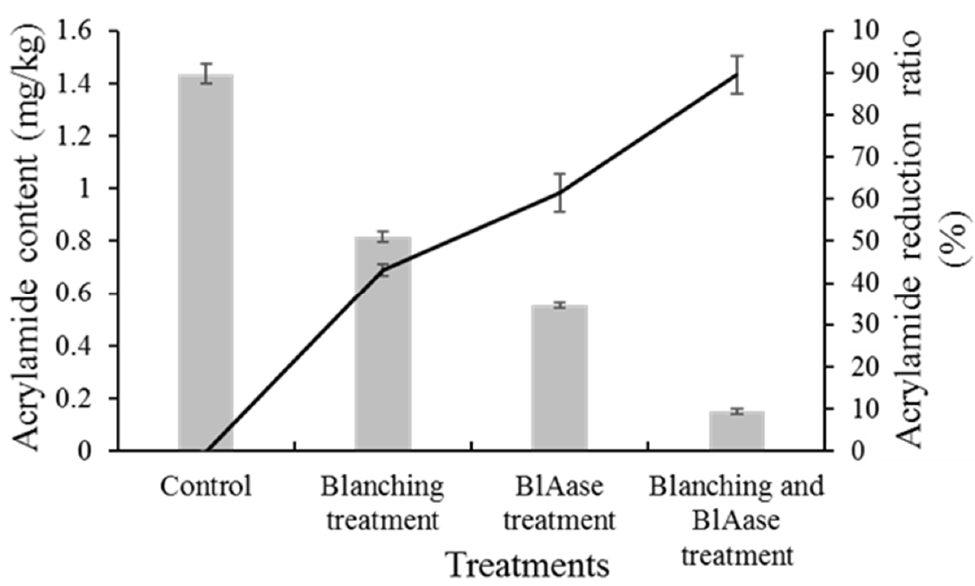
Figure 8. Acrylamide levels in potato chips subjected to different treatments.